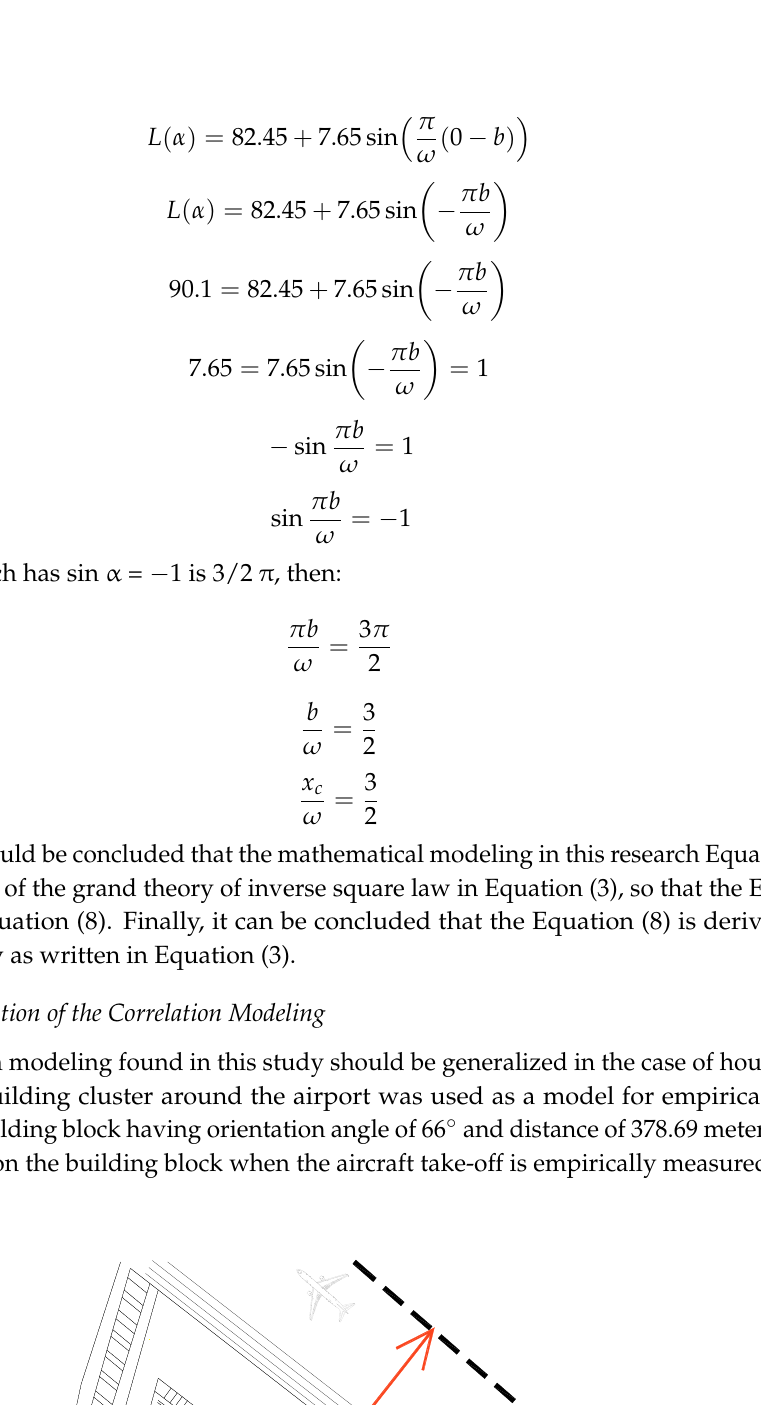
Figure 17. Empirical Noise level (OS-T) of 66° oriented building toward runway. The descriptive statistic based on the empirical noise level data of the building block is shown in Table 18. Table 18. Descriptive Statistic of empirical noise level data on the 66° oriented building to runway. Condition